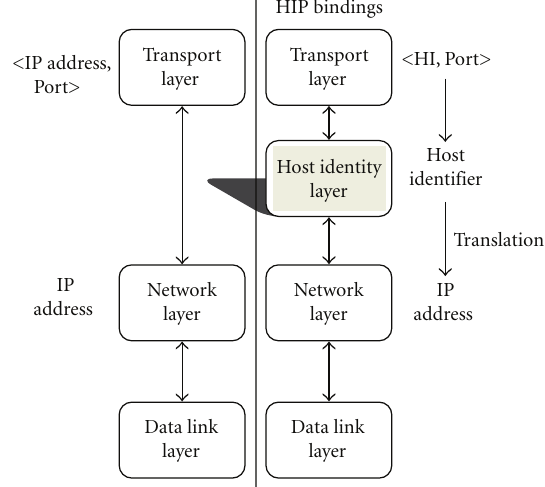
Figure 2: Comparison between current IP and HIP